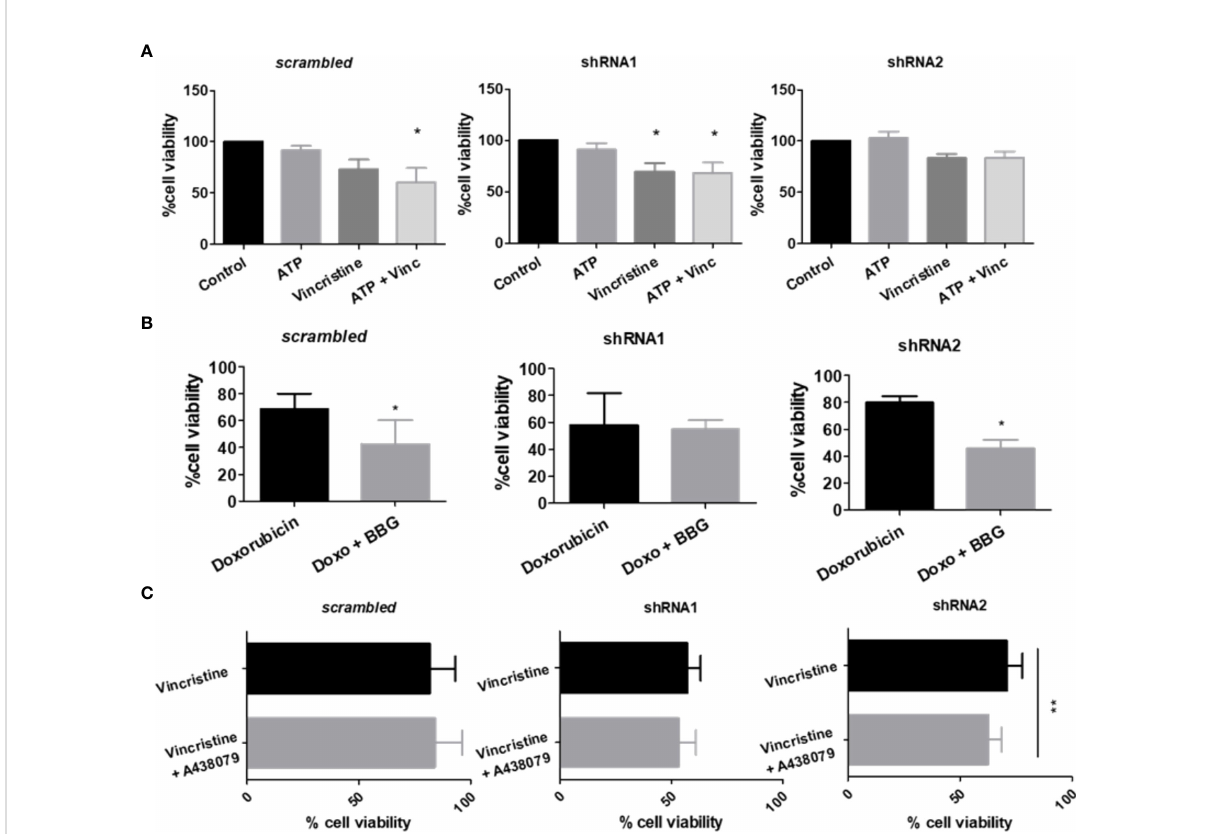
FIGURE 2 P2X7 receptor activity in response to chemotherapy. (A) Cell viability measurements of ACN cells stimulated or not with ATP, the endogenous P2X7 receptor agonist, alone or in combination with vincristine (n>=3). (B) Cell viability measurements of ACN cells stimulated with doxorubicin (doxo) in the presence or absence of the P2X7 receptor antagonist Brilliant Blue-G (BBG) (n>=4). (C) Cell viability measurements of ACN cells stimulated with vincristine in the presence or absence of the P2X7 receptor-speci fi c antagonist A438079 (n>=4). Values were calculated as detailed in Methods section item 5. * p <0.05 and ** p